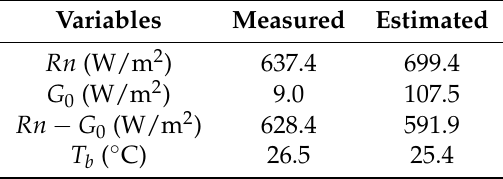
Table 2. Measurements of radiative terms at the Yingke station for the 7 July 2008 at 11:30 a.m. (Beijing